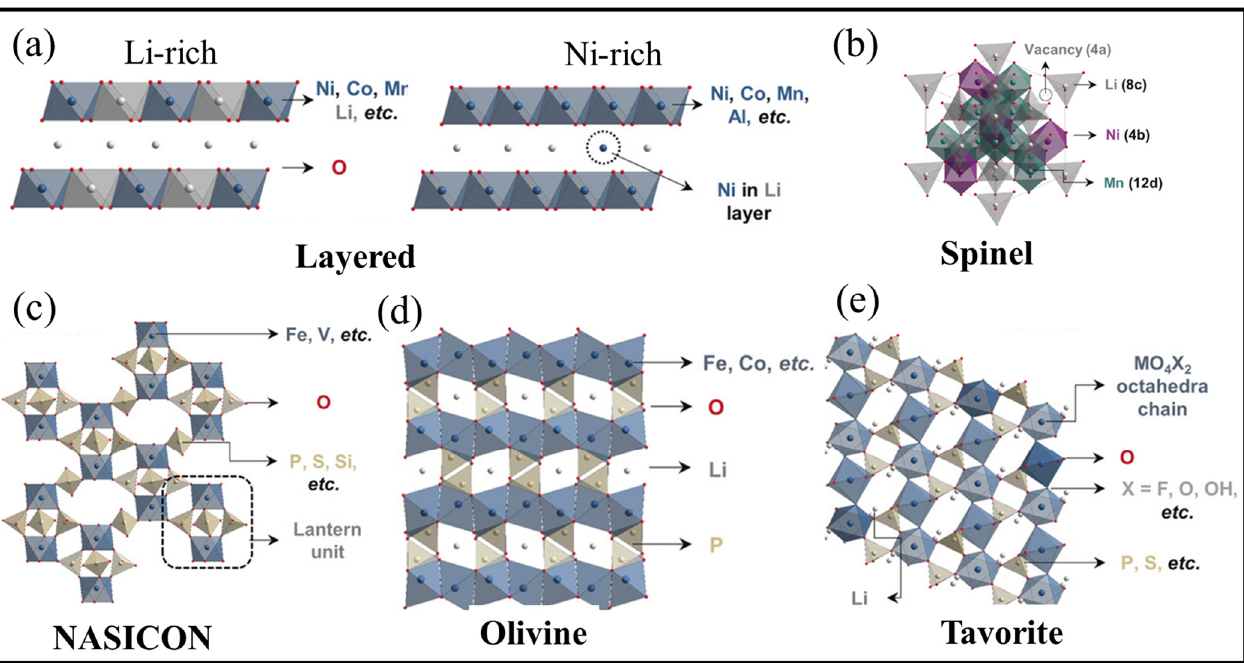
Figure 6. Schematic representation of the crystal structure of various cathode materials: ( a ) layered, ( b ) spinel, ( c ) NASICON, ( d ) Olivine, and ( e ) Tavorite [188].